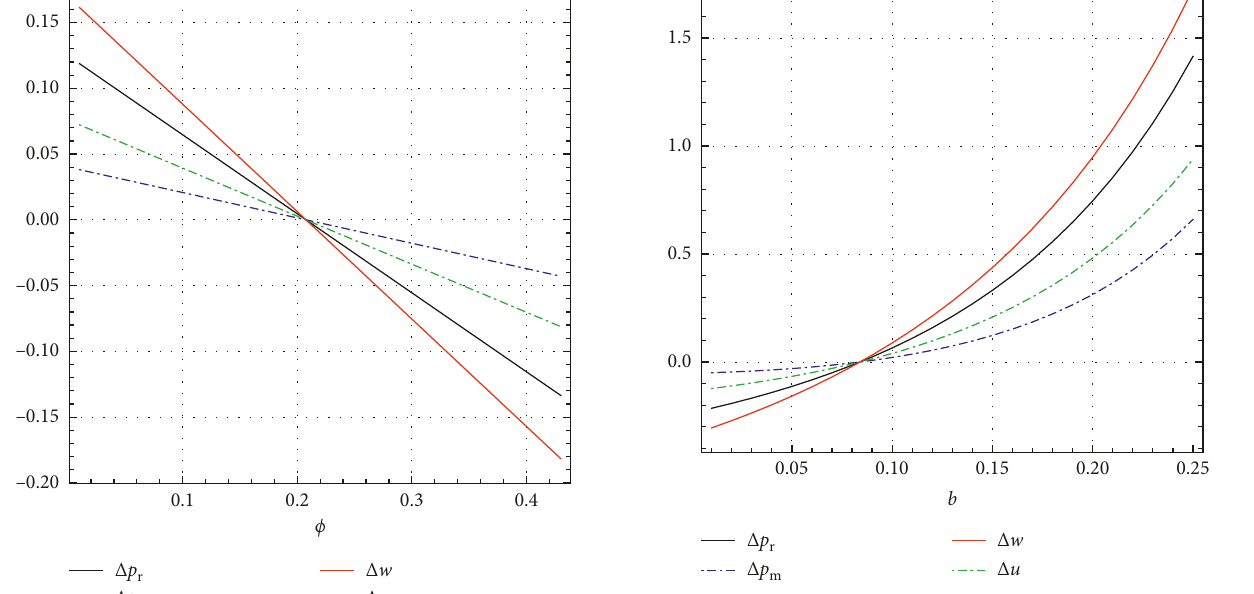
Figure 3: Comparison of steady-state decisions with b